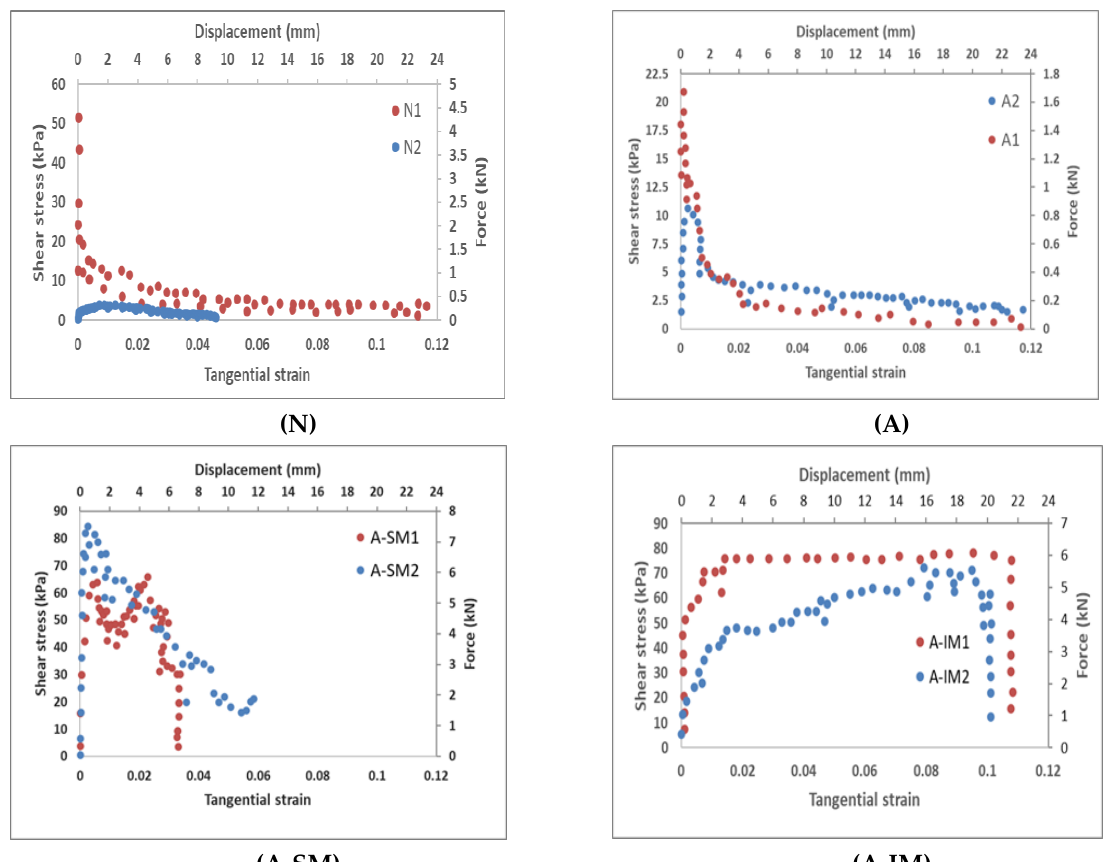
Figure 6. Experimental results: force vs. relative displacement of concrete with respect to CFRP and shear stress vs. average tangential strain of the connection area.